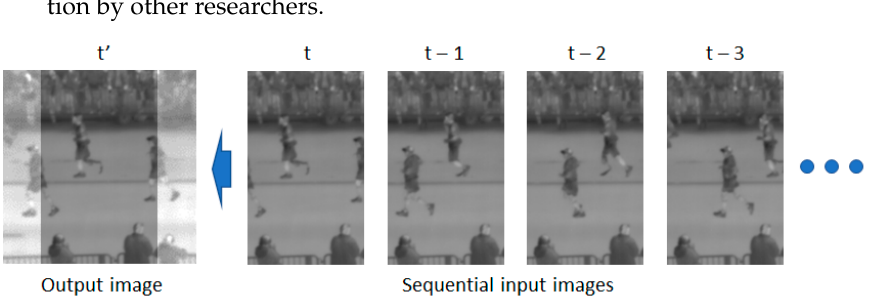
Figure 1. Example of thermal image prediction.